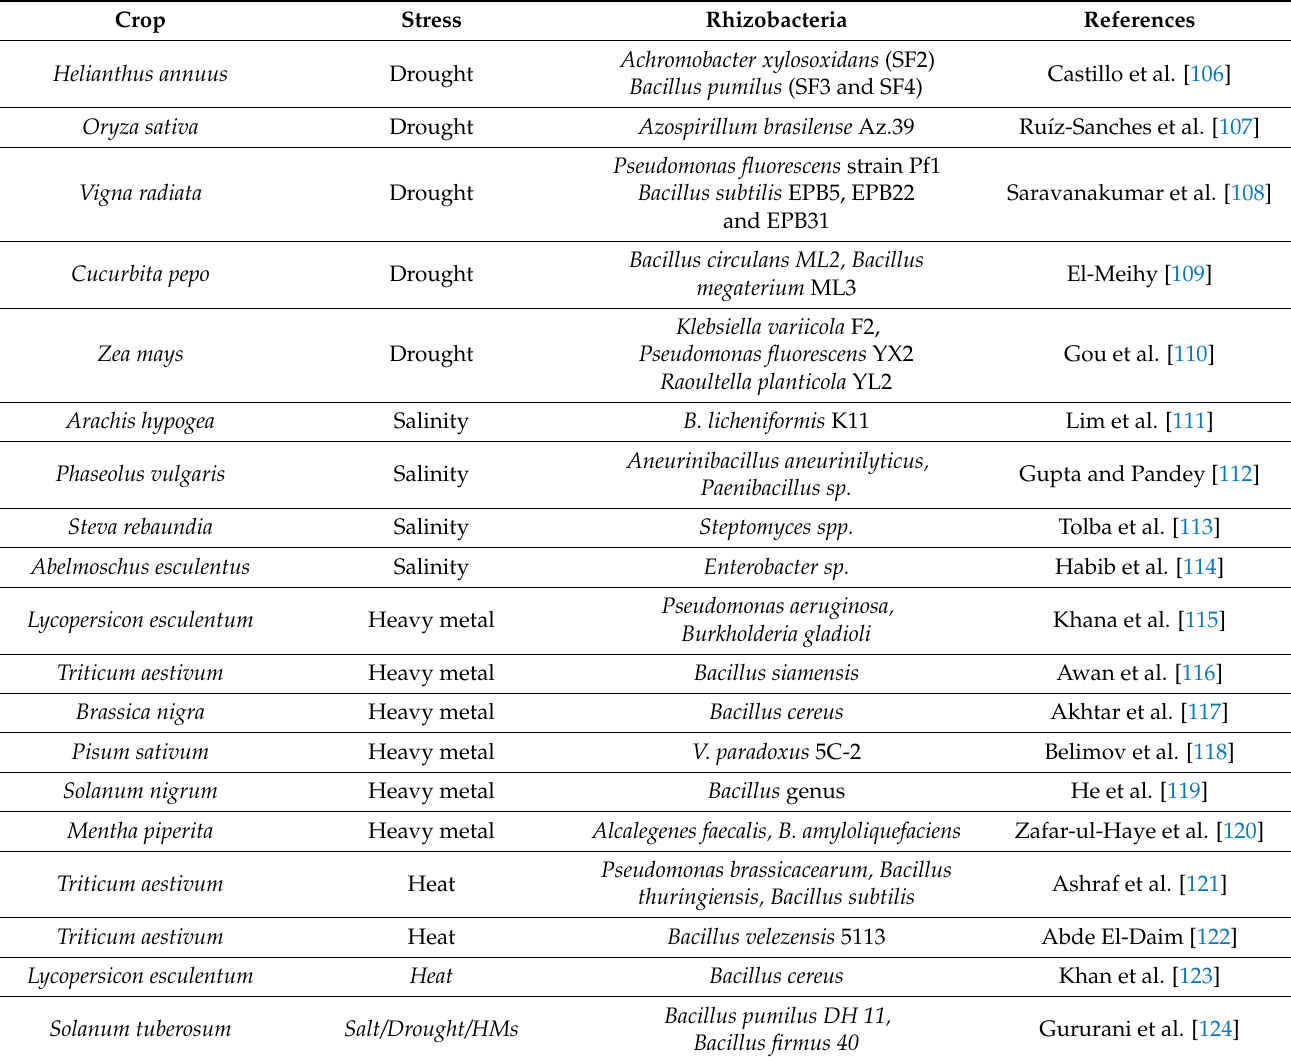
Table 1. List of rhizobacteria species responsible for abiotic stress tolerance in common crop plants. Crop Stress